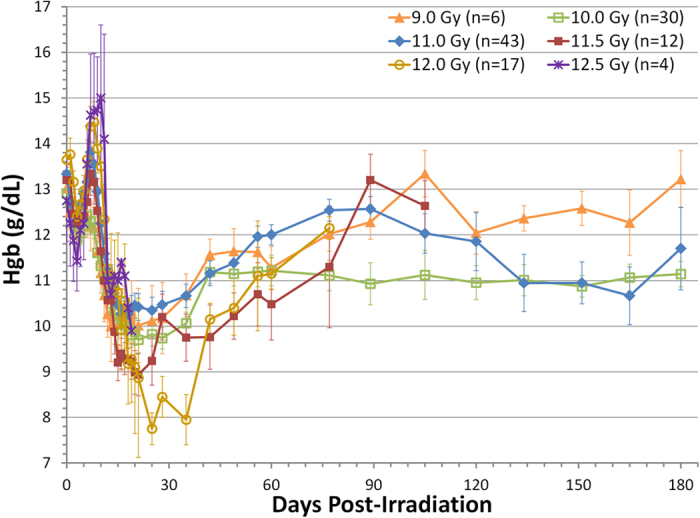
Time course of plasma hemoglobin in NHP exposed to 9.0–12.5 Gy PBI/BM5.Mean values (±s.e.m) are plotted for NHP grouped into each dose cohorts at each time point.